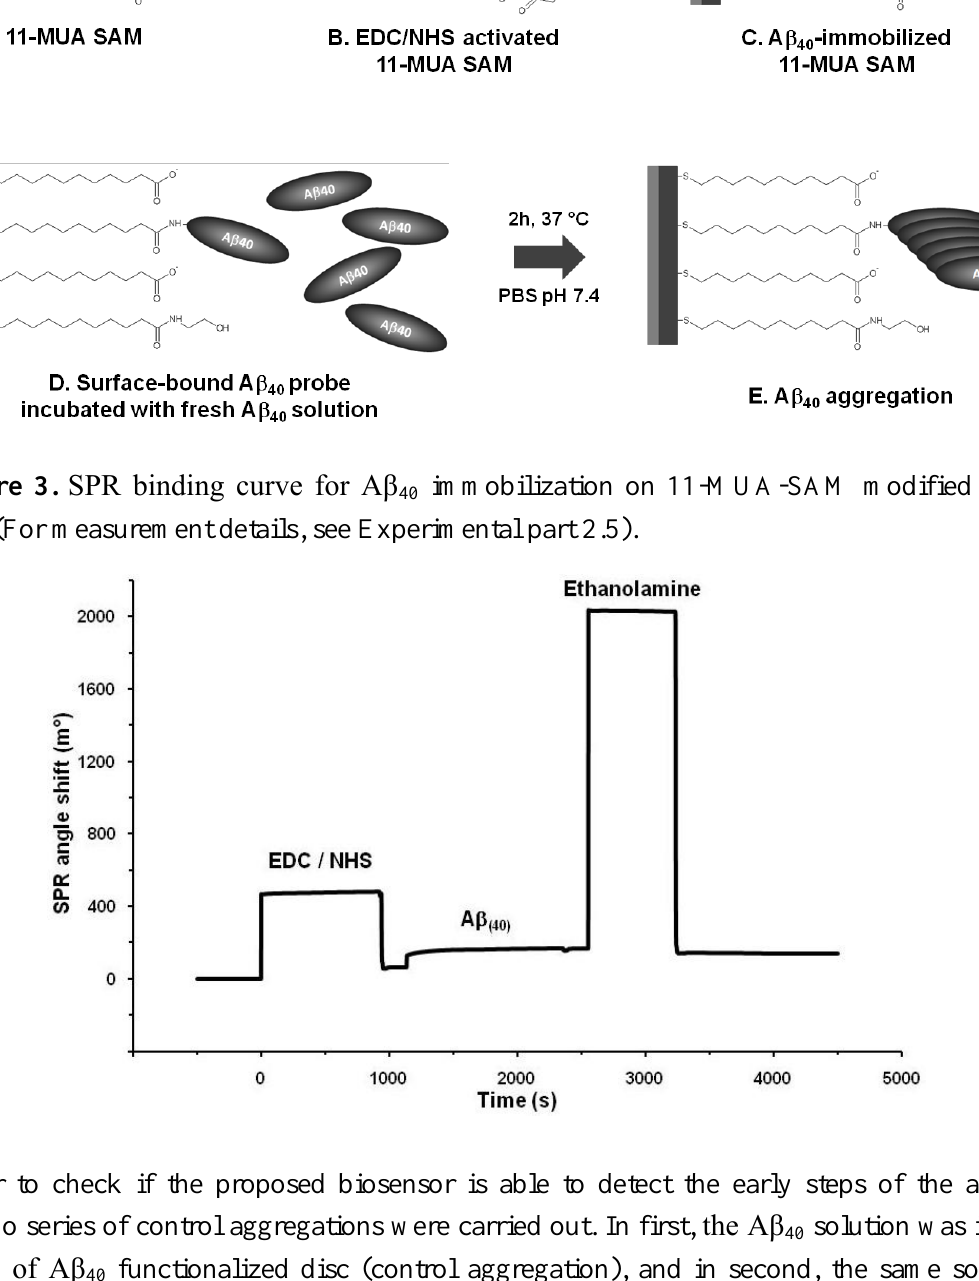
Figure 2. Scheme of Aβ probe immobilization on 11-MUA-modified surface of SPR gold 40 disc ( A–C ) and Aβ aggregation assay on Aβ -functionalized gold discs surface ( D–E ). 40 40